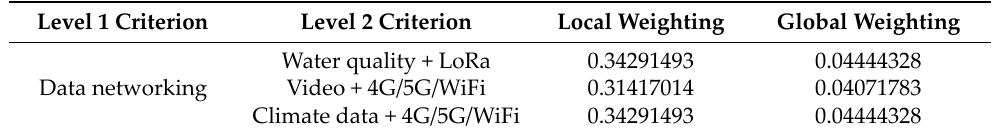
Table 8. Level 2 priority evaluation results for Level 1 ‘data networking’ criterion using the modified